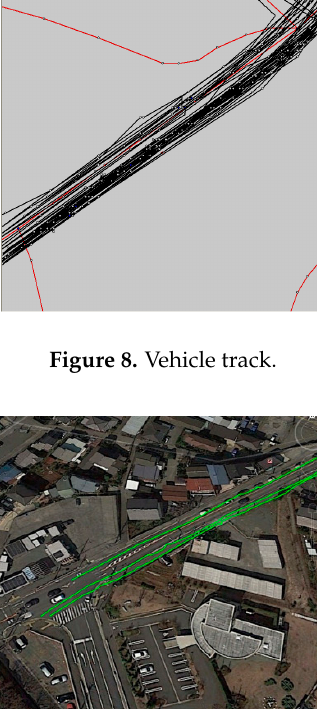
Figure 9. Lane path.